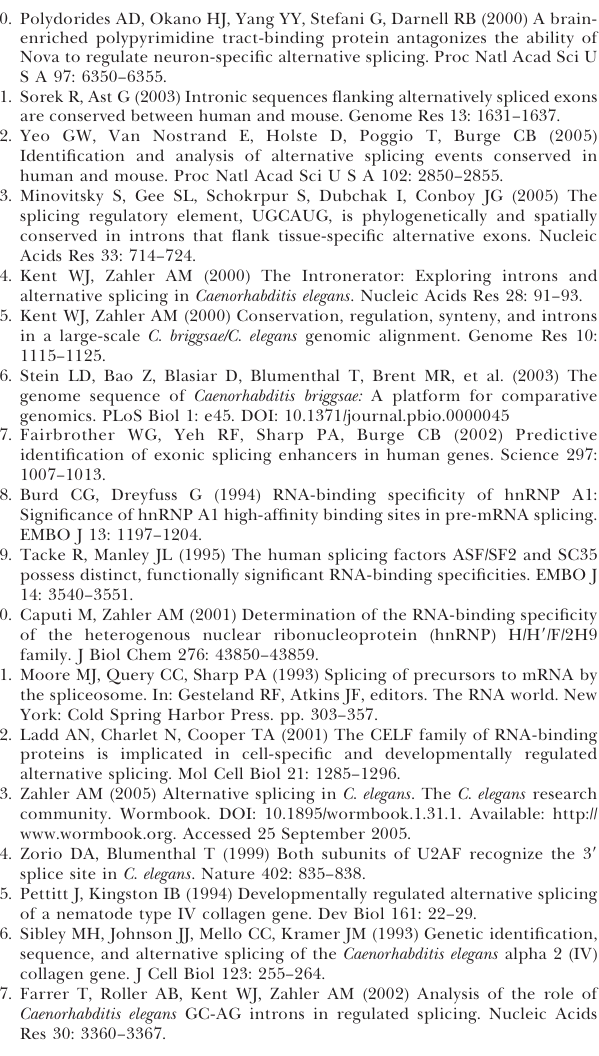
Table S1. Complete Database of Highly Conserved Intronic Elements Used in Motif Analysis Column (A) indicates C. elegans gene name. Columns (B–AI) list the WABA high homology sequences found in C. elegans introns flanking alternative exons of the corresponding gene. Table S2. Complete Table Detailing Ranks of Pentamer and Hexamer Motifs in Introns Lacking Evolutionary Conservation Surrounding 307 Alternatively Spliced Exons On both worksheets: Column (A) represents rank of motif from search based on obs/exp frequency in introns lacking evolutionary conservation downstream of alternative introns. Column (B) denotes motif and (C) contains the number of times the motif was observed in the dataset. (D) The observed frequency of the motif in the dataset. (E) Contains the expected frequency of motif based on total intron dataset. Column (F) is the ratio of observed frequency to expected frequency. Columns (H–M) are data from the same analysis in the same order for upstream introns. Table S3. Each Row in the Table Represents a Different Spliced Isoform of the unc-52 Reporter Constructs, and Each Column Denotes the Reporter Being